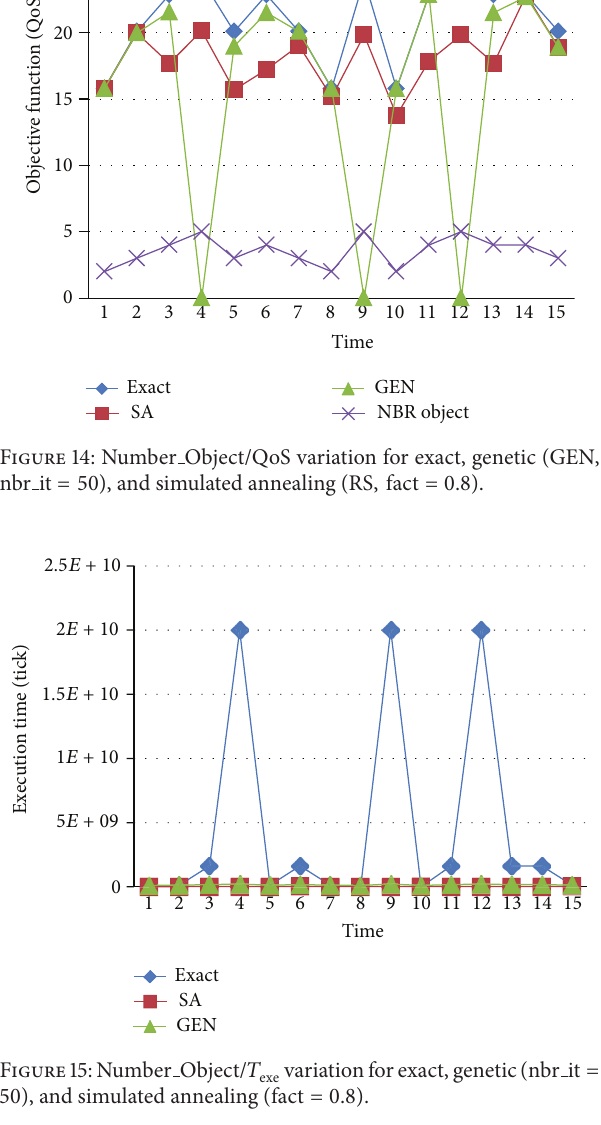
variationforexact,genetic ( nbr it = exe